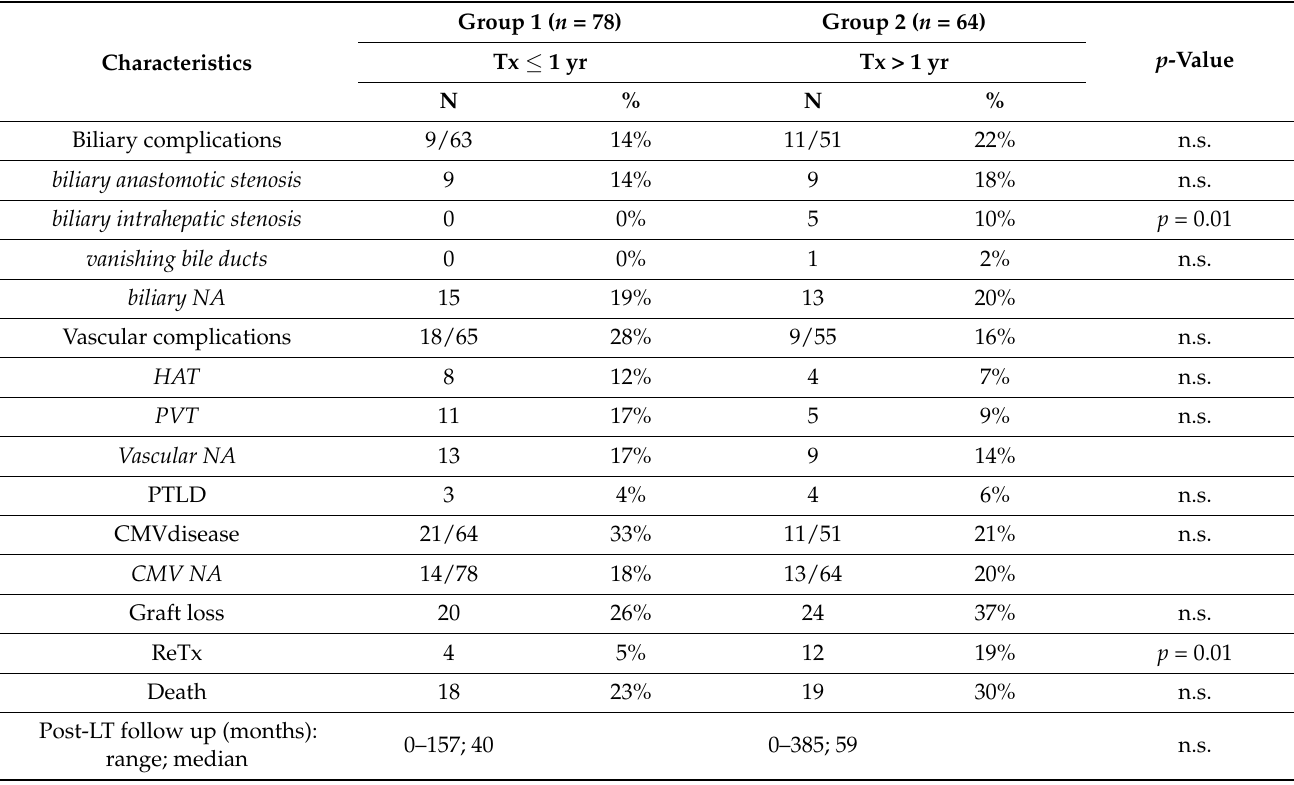
Table 4. Characteristics of 72 pts transplanted before 2011 (Group 1) and 70 pts transplanted since 2011 (Group 2). Data corrected for availability (removal of missing data).